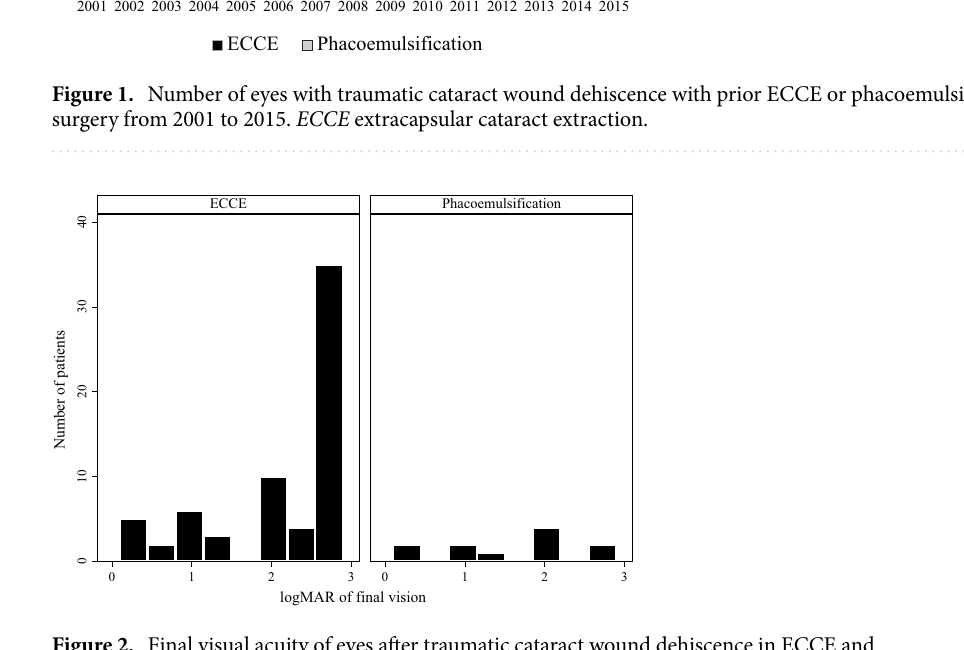
Figure 2. Final visual acuity of eyes after traumatic cataract wound dehiscence in ECCE and phacoemulsification groups. In cases of VA of < 0.05, finger counting at 2 feet, hand movement, only light perception, and no light perception were assigned logMAR values of 2.0, 2.3, 2.6, and 2.9, respectively. ECCE extracapsular cataract